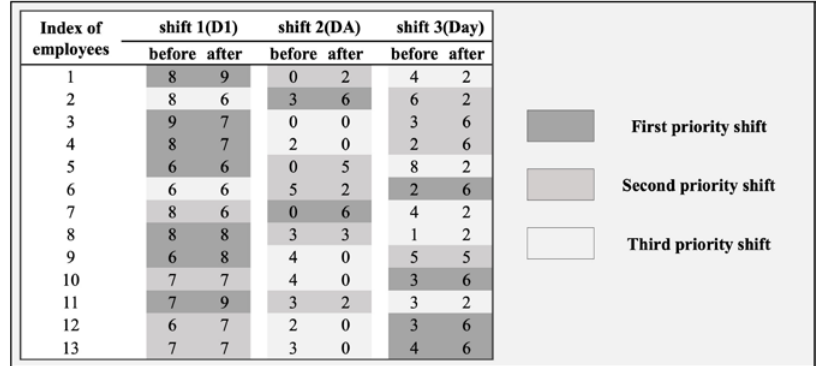
Figure 5. Change in preferred shift placement number for each worker.